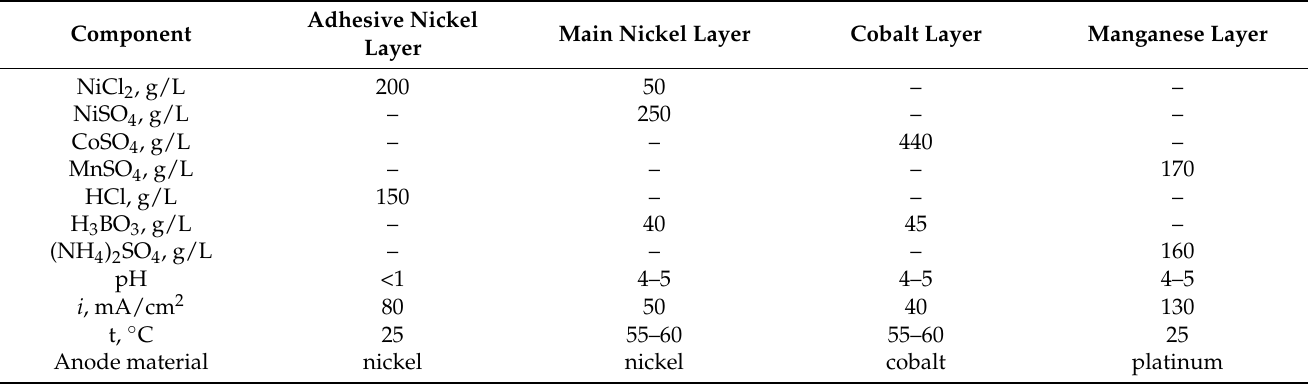
Table 2. Compositions of electrolytes and modes of deposition of metal